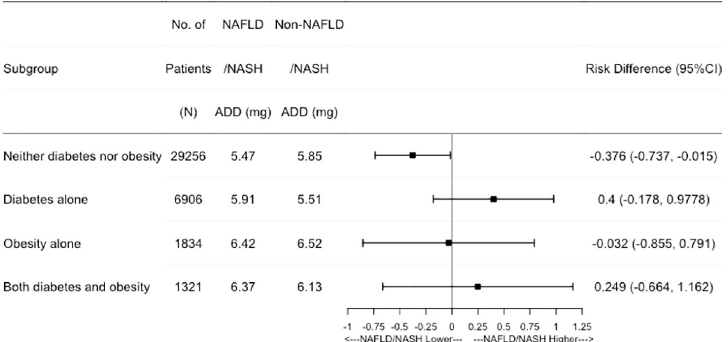
Fig 3. Adjusted effect estimate of NAFLD/NASH on average daily dose of warfarin using the propensity score stratification approach after the first 2 months of warfarin use. Note: NAFLD: Nonalcoholic Fatty Liver Disease; NASH: Nonalcoholic Steatohepatitis; ADD: Average Daily Dose.